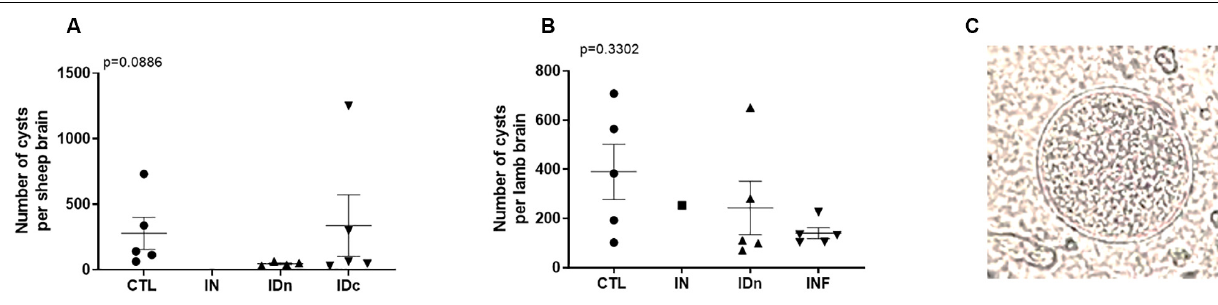
from non-vaccinated group (CTL), intradermal vaccinated group (IDn), or primary infected group (INF) were approximately the same: 5/9 (55%), 5/8, and 5/8 (62%), respectively. Concerning lambs from intranasally vaccinated group (IN), only one brain (12%) was positive among eight. For cyst-positive brains ( Figure 8B ), no significant differences were observed between groups due to heterogeneity of results (overall p = 0.3302; IDn: min 70 to max 651) but a tendency to decrease the number of cyst per brain was still observed in two vaccinated groups (IN: 253, IDn: 111) or the primary-infected animals (INF: 132) vs control (CTL: